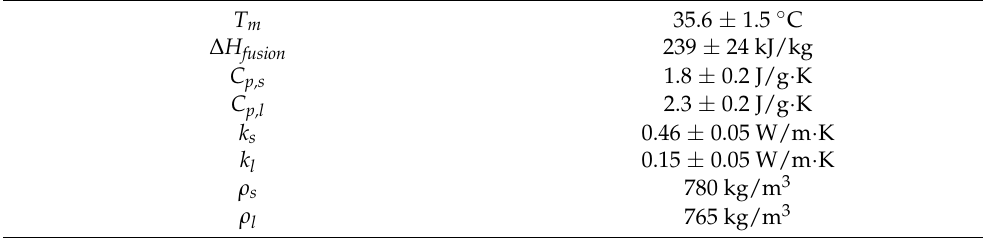
Figure 2. Photographs of the mock tablets showing the: ( a ) internal components with the back cover removed; ( b ) back cover; and ( c ) front display.